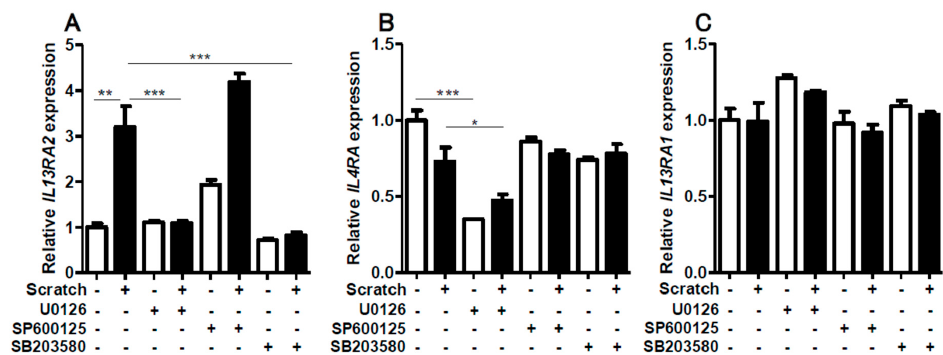
Figure 7. The effect of MAPK inhibitors on IL13RA2 ( A ), IL4R ( B ), and IL13RA1 ( C ) expression. Non-scratched and scratched confluent keratinocytes were treated with or without U0126 (MEK 1/2- ERK1/2 inhibitor), SP600125 (JNK inhibitor), and SB203580 (p38MAPK inhibitor). Data is shown as the mean ± SEM. * p < 0.05, ** p < 0.01, *** p <